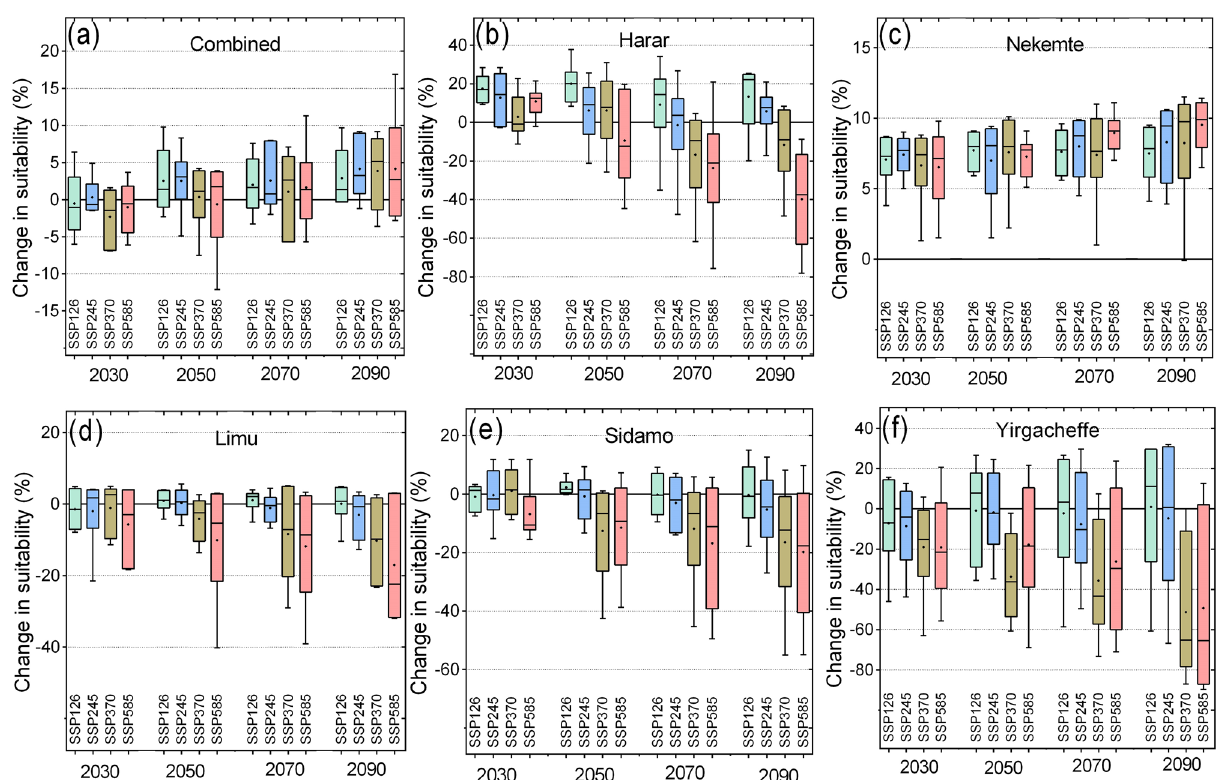
Figure 4. Simulated impacts of climate change on specialty coffee suitability in Ethiopia by 2030s, 2050s, 2070s and 2090s. The bar plots show the range of projected changes using the ensemble model and the variability from the six